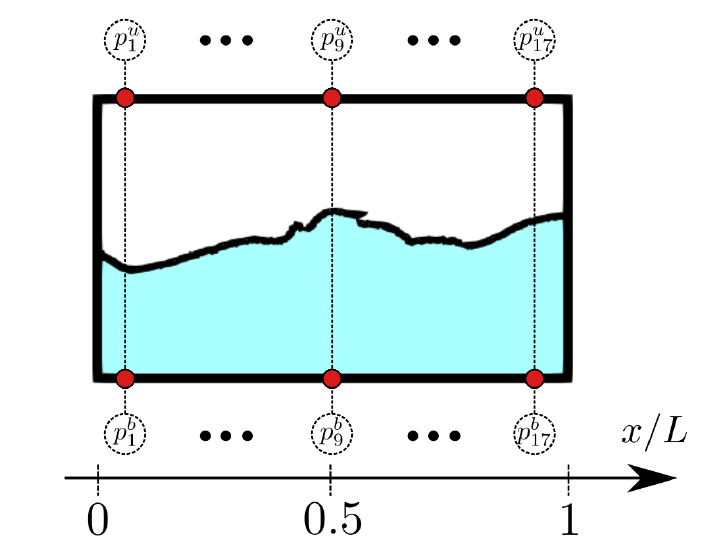
Figure 18. Outline of the pressure sensor distribution when 34 sensors are used.